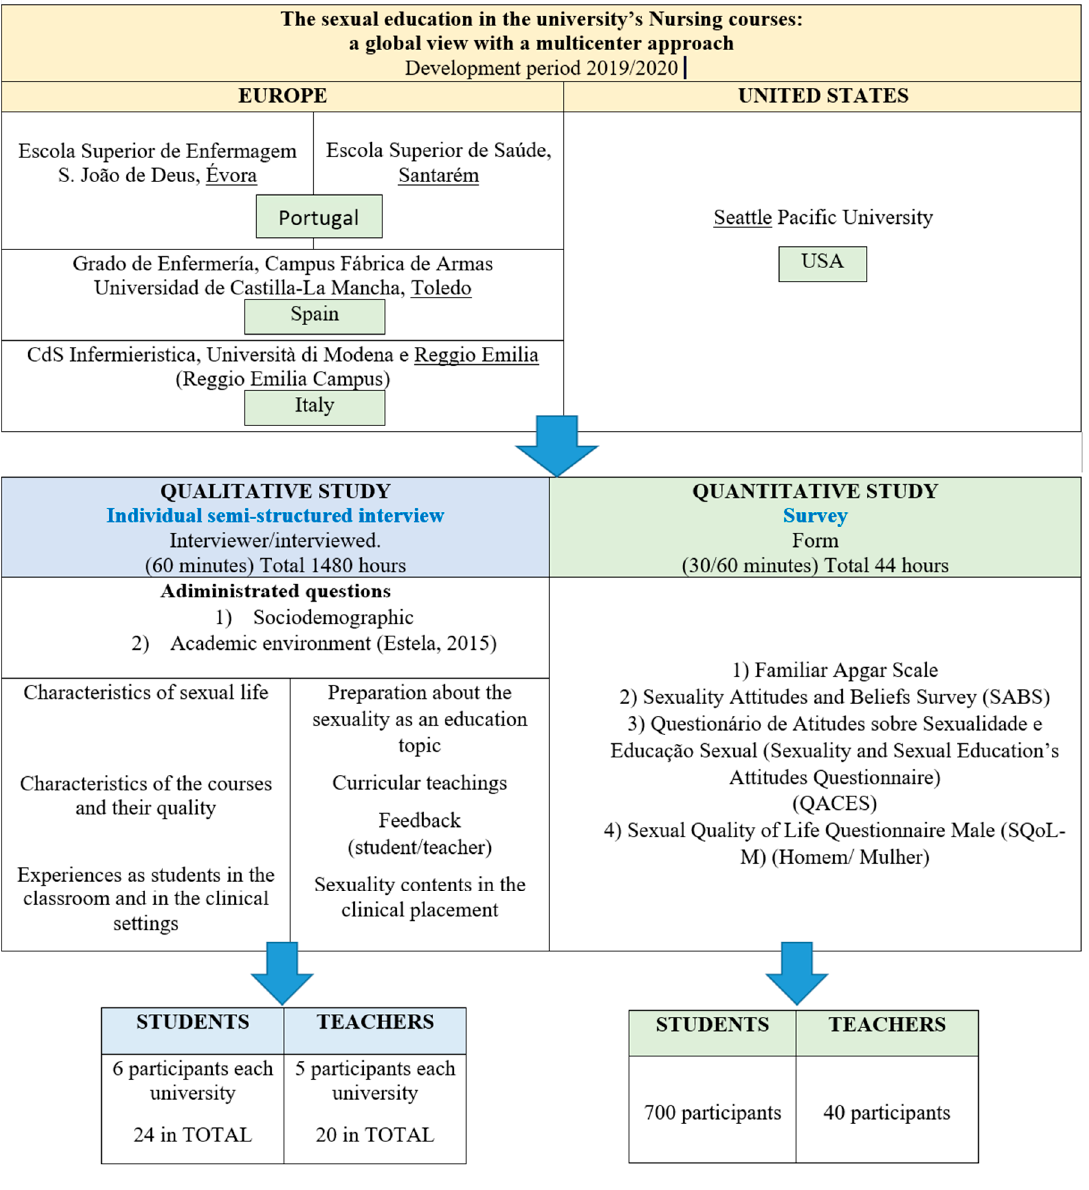
Figure 1. Project plan. Source created by the authors.